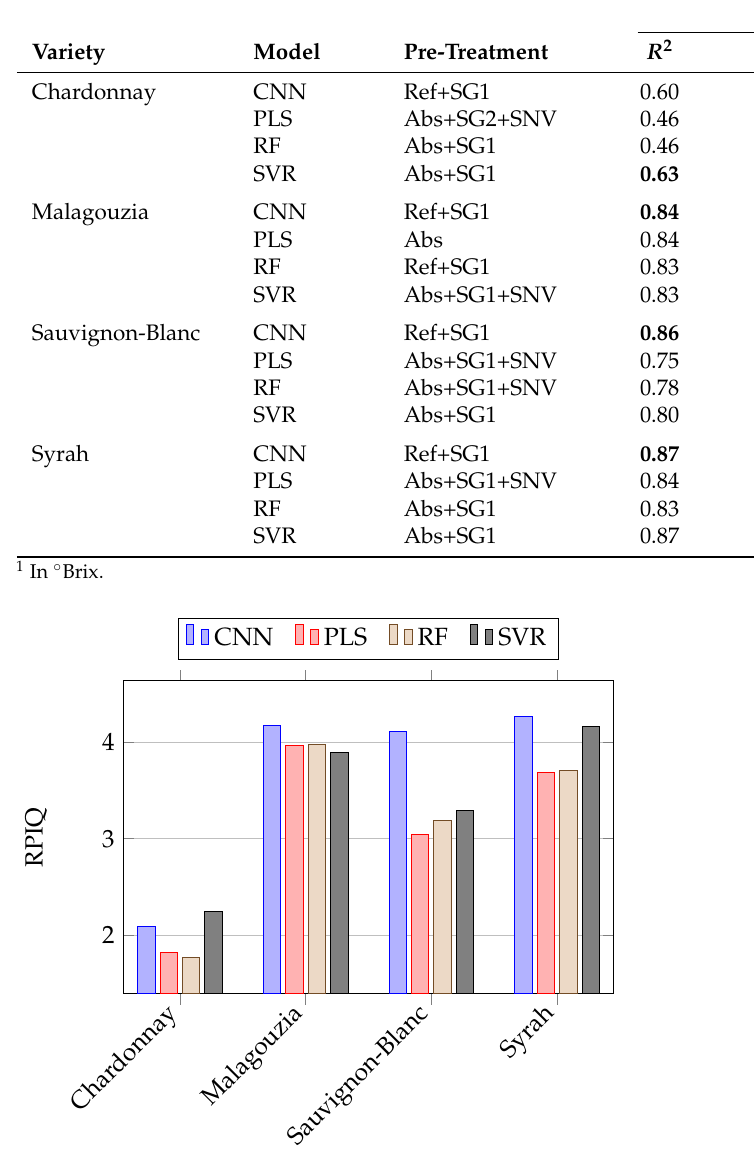
Figure 9. Visual comparison of the RPIQ metric (higher is better) of Table